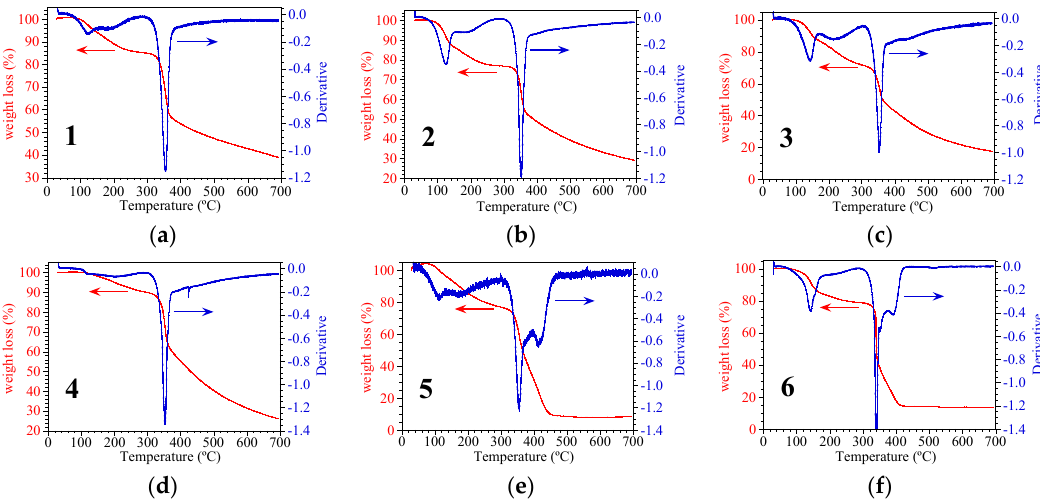
Figure 3. Thermogravimetric measurements and the corresponding derivative curves in the temperature range 30–700 ° C for compounds 1 ( a ), 2 ( b ), 3 ( c ), 4 ( d ), 5 ( e ), and 6 ( f ). Table 3. Experimental and calculated weigh losses (%) for compounds 1 – 6 at the first plateau at around 250–300 °C . Compound Range ( ◦